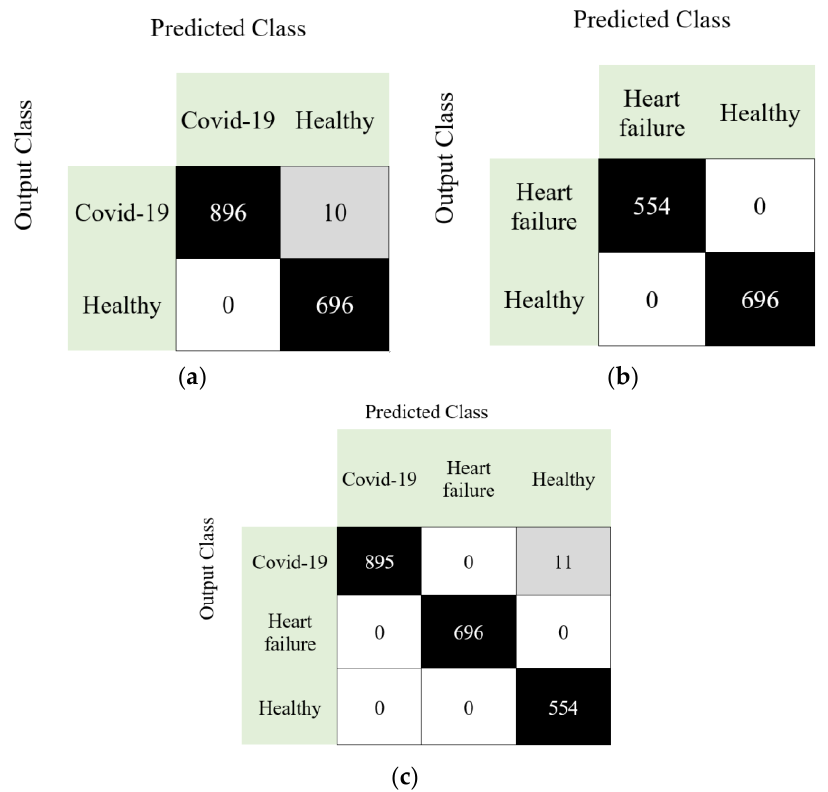
Figure 5. Confusion matrices obtained for various Cases ( a ) Case1, ( b ) Case2, ( c ) Case3.